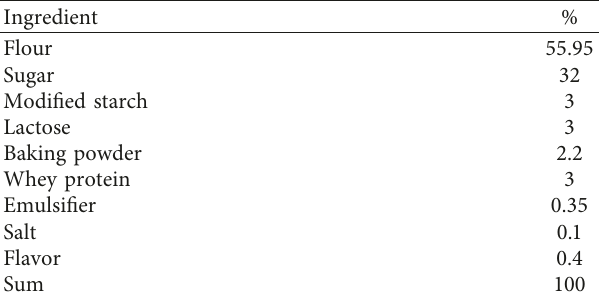
Table 3: Control cake formula.